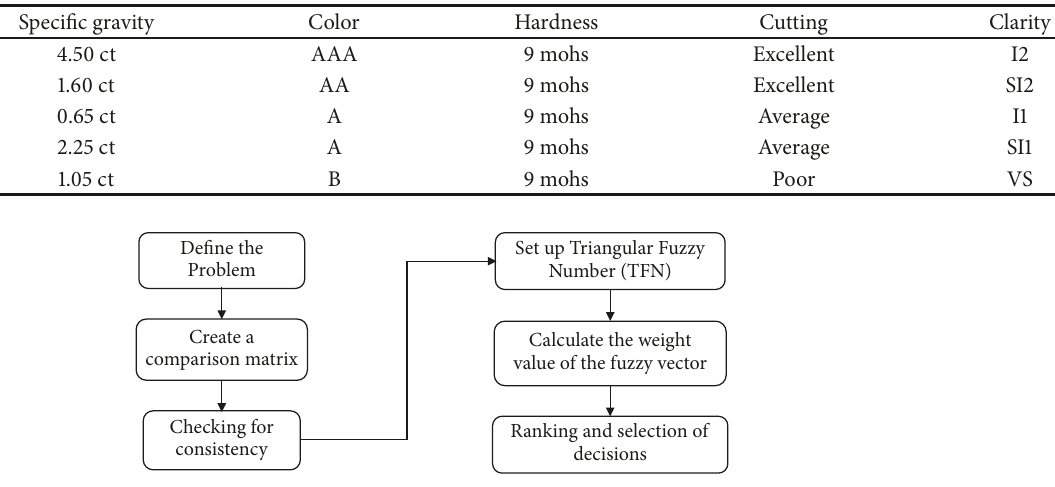
Figure 1: Block diagram has six steps of F-AHP phase